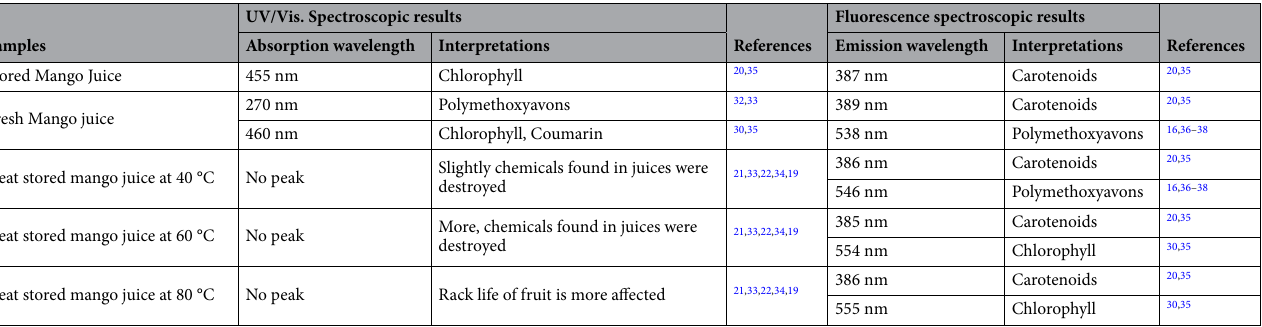
Table 1. UV/Vis and Fluorescence Spectroscopic results of stored, fresh and heat-treated mango fruit juices compared with various literature.